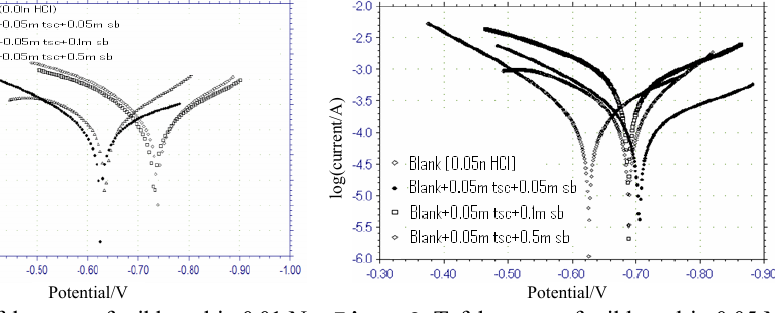
Figure 2 . Tafel curves of mild steel in 0.05 N HCl in absence and presence of various